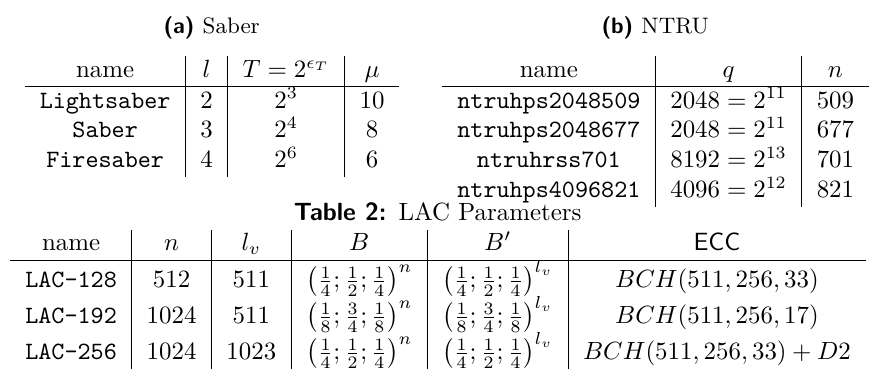
Table 1: NTRU and Saber Parameter Sets